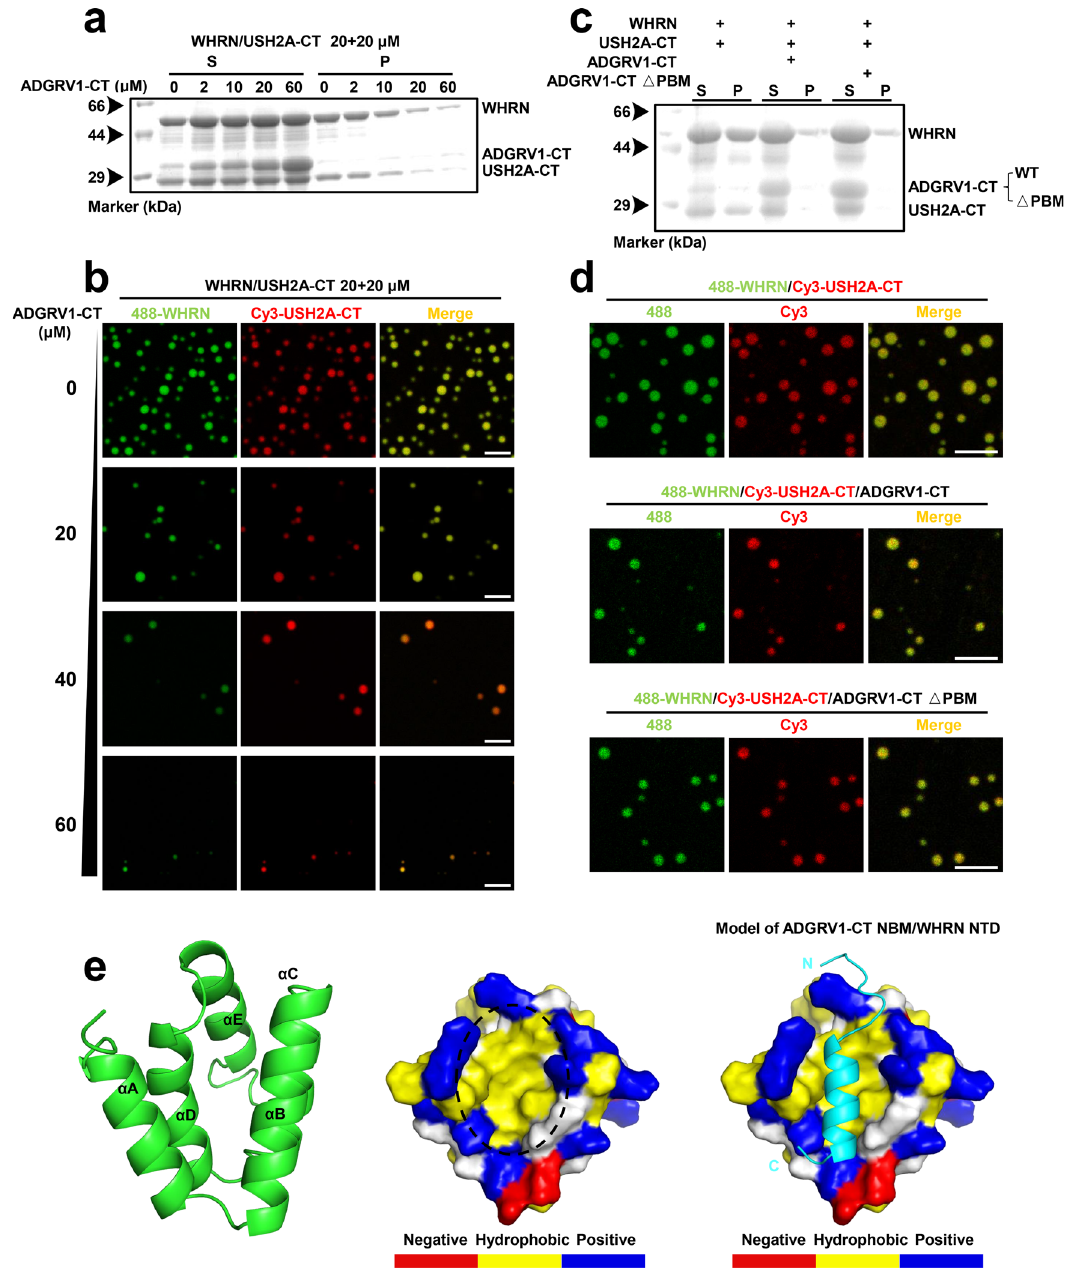
Fig. 6 | High concentration ofADGRV1-CT disassembles the USH2condensates formed by phase separation. a Co-sedimentation-based assay showing that the pellet enrichments of both WHRN and USH2A-CT in WHRN/USH2A-CT (20 μ M each) were decreased by ADGRV1-CT concentration-dependently at 0 – 60 μ M. b Fluorescence images showing the droplets formed in WHRN/USH2A-CT decreased in both number and size by ADGRV1-CT concentration-dependently at 0 – 60 μ M.WHRNandUSH2A-CTwerelabeledwithAlexa488andCy3,respectively. Scale bar: 5 μ m. c Co-sedimentation-based assay showed that the decrease in the pellet enrichment of WHRN, USH2A-CT, or ADGRV1-CT was not much changed when PBM was truncated ( △ PBM) from ADGRV1-CT. d Fluorescence images show that the amounts and sizes of the droplets formed by WHRN/USH2A-CT was still